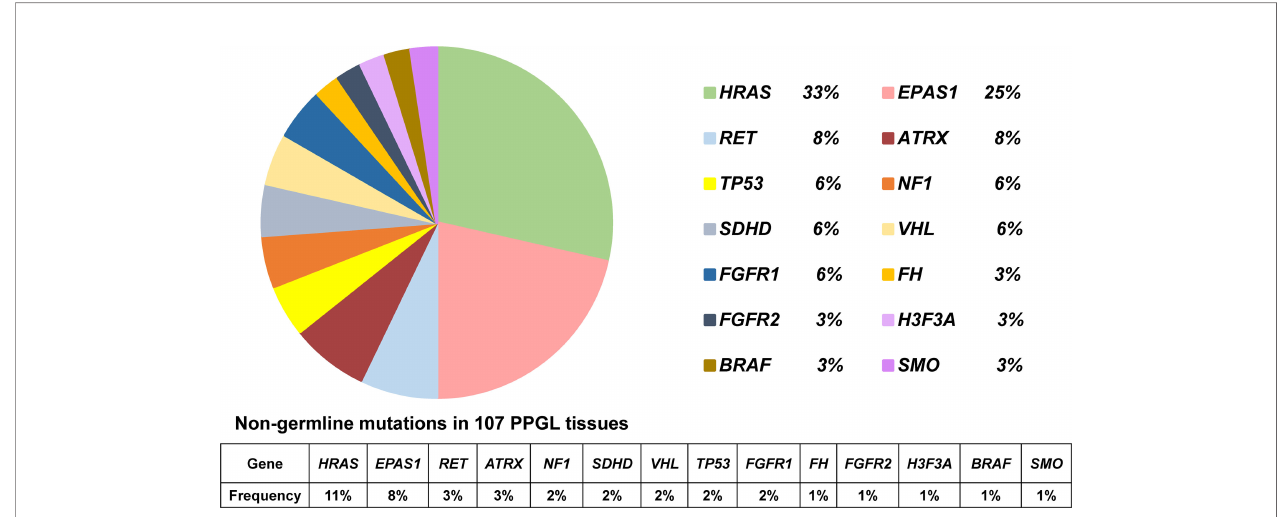
FIGURE 2 | Pie diagram showing the distribution of nongermline mutations in PPGL. Circular statistical graphic was used to illustrate the proportion of nongermline mutations.